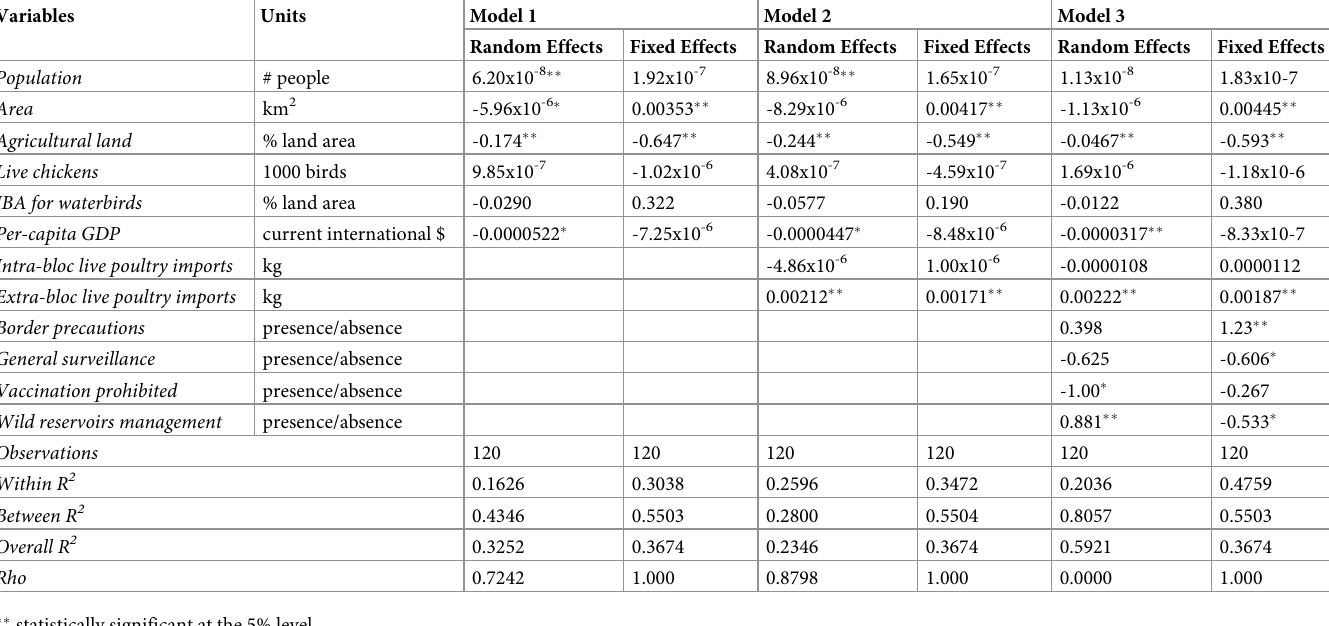
Table 3. Results from the regression models of H5N1 poultry outbreak risk factors for the Association of Southeast Asian Nations (ASEAN); regressor coefficients are reported and statistically-significant factors are marked by. A blank space signifies that the variable was not included in the given